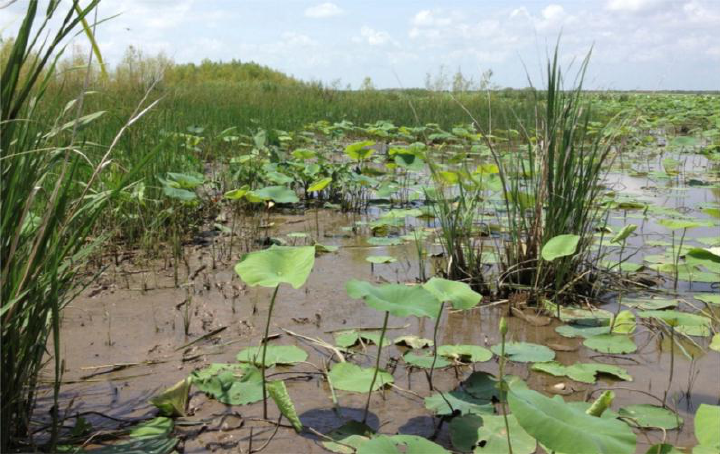
Figure 4. Boundary between the low freshwater marsh ( Typha spp.) and the lower, intermittently exposed aquatic zone ( Nelumbo lutea ) of Wax Lake Delta, Louisiana (USA), with a pioneer patch of rushes at the lower elevation. (Photo credit: Amber